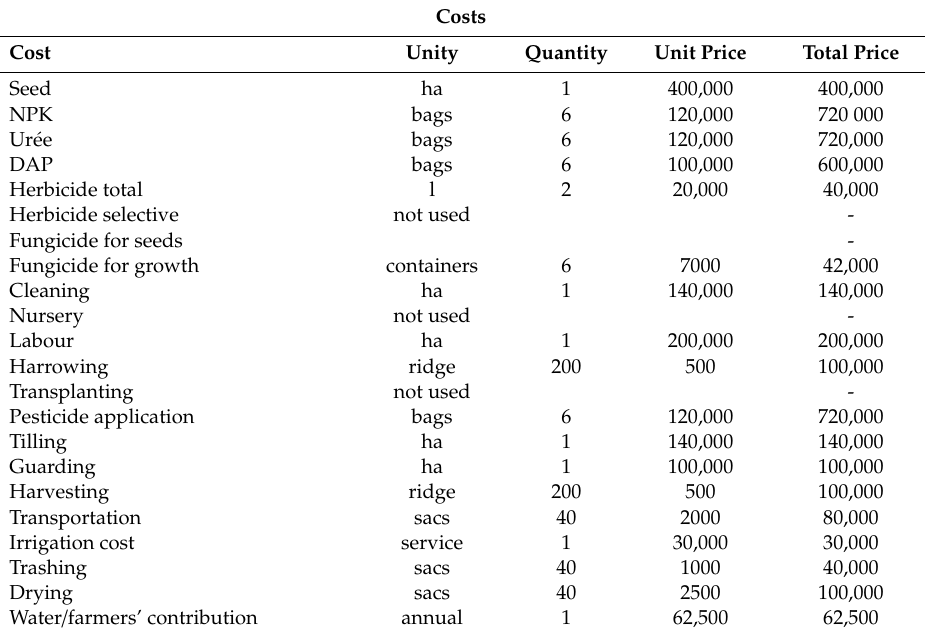
Table A2. Cost-benefit analysis of rice production (in UGX) in Mubuku,